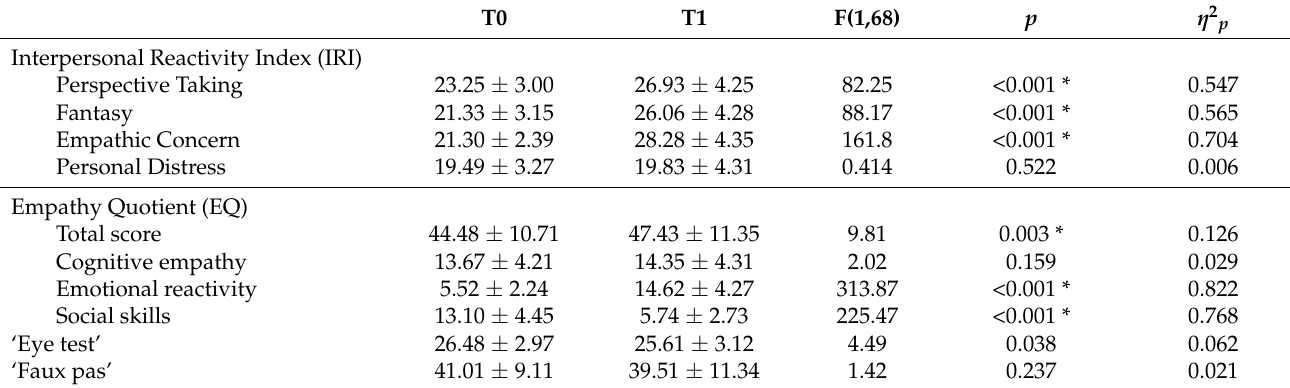
Table 1. Effect of time on empathy